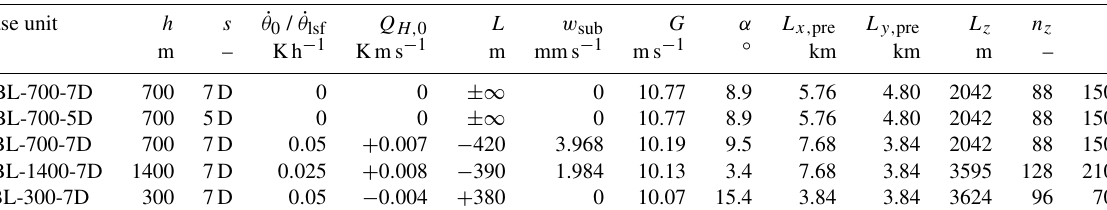
Table 1. Overview of simulated cases with boundary layer height h , turbine spacing s , surface heating rate ˙ θ 0 or large-scale forcing advection tendency ˙ θ lsf in the case of SBL-300-7D, surface heat flux Q H, 0 , Monin–Obukhov length L , subsidence velocity w sub , geostrophic wind speed G and direction α , length and width of the precursor domain L x, pre and L y, pre , domain height L z , number of vertical grid points n z , stretch level z s , and Rayleigh damping level z rd .